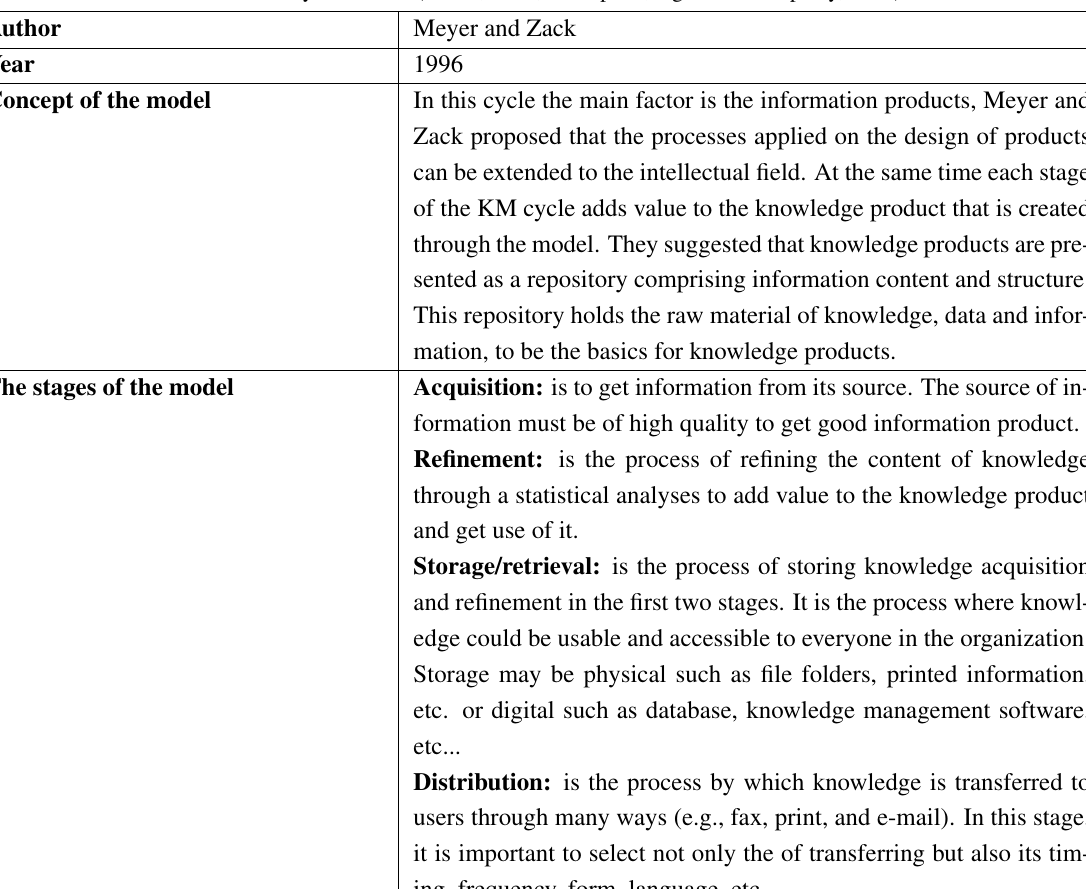
Table 2. KM cycle models (Dalkir, 2005; Mohapatra, Agrawal & Satpathy,